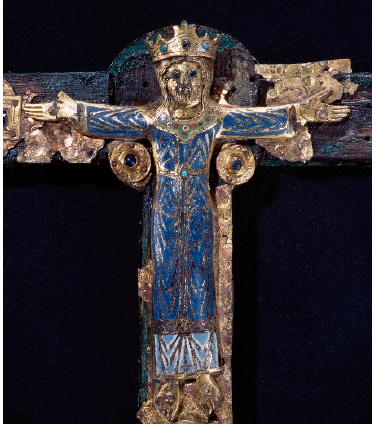
Figure 6. Limoges crucifix. 13th century. Oslo. Museum of Cultural History. Inv. No. 21300. Photo: Not identified (CC BY-SA 4.0).